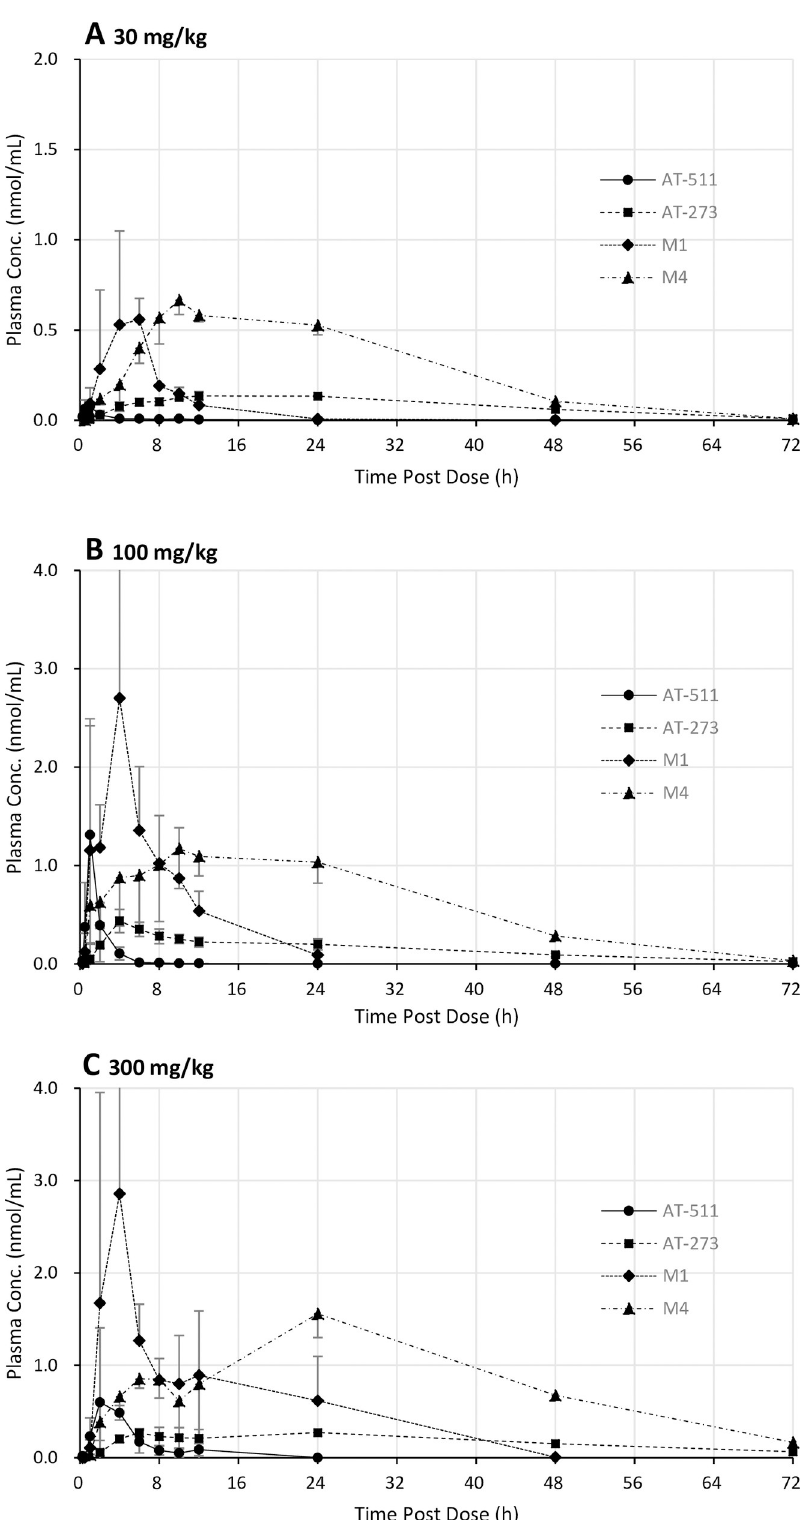
Fig 7. Mean profiles of AT-511 and its metabolites in monkey plasma over 72 h. Cynomolgus monkeys (groups of 3 males per dose) were administered a single oral dose of AT-527 at (A) 30 mg/kg, (B) 100 mg/kg and (C) 300